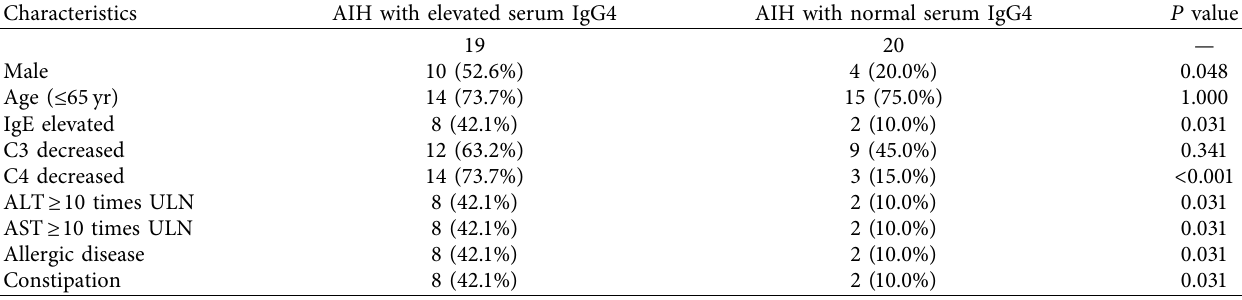
Table 2: Comparison of AIH patients with elevated serum IgG4 with those with normal IgG4 levels.